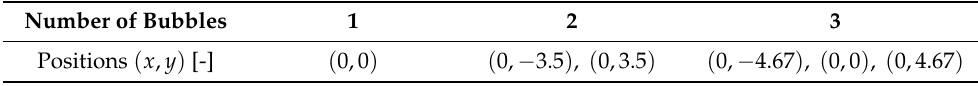
Table 1. Bubble positions of each case.